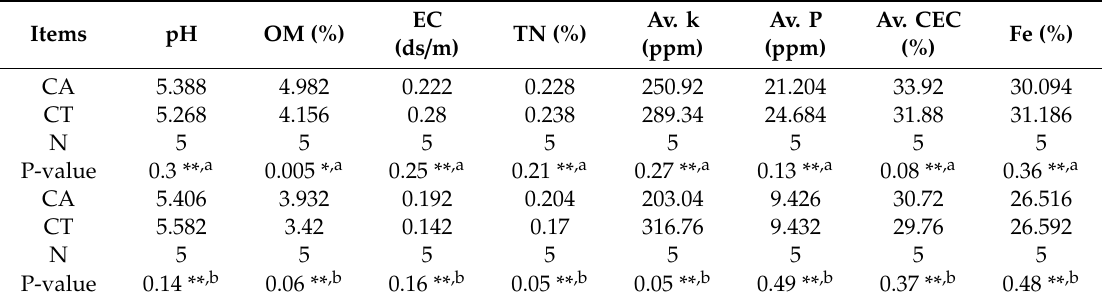
Table A2. A one tailed paired t-test for the average depth integrated soil physico-chemical properties taken from Dangishta experimental